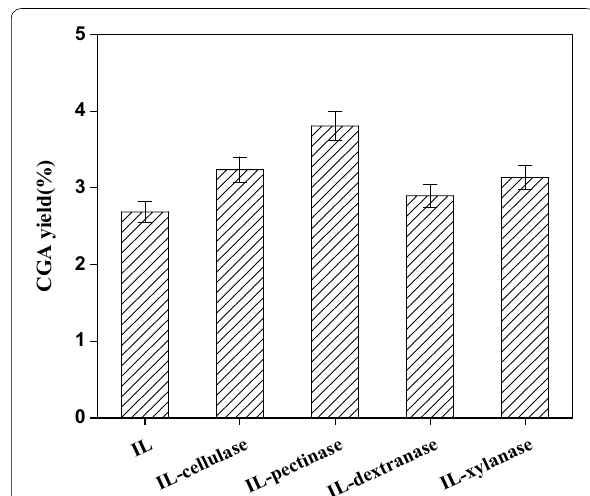
Fig. 1 Effect of different enzyme types on the extraction yield of CGA from FLJ